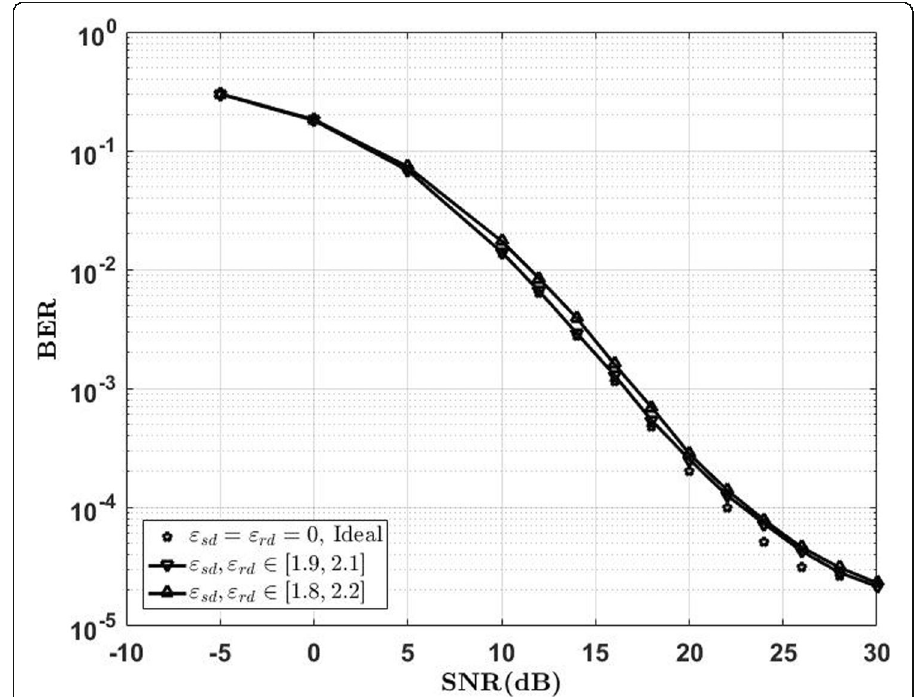
Fig. 7 BER performance of systems without coding versus SNR for the proposed MCFO compensation algorithm. Figure 7 depicts the BER performance of systems without coding versus SNR for the proposed MCFO compensation algorithm, and the simulation setup is no frequency offset no compensation. ε rd , ε